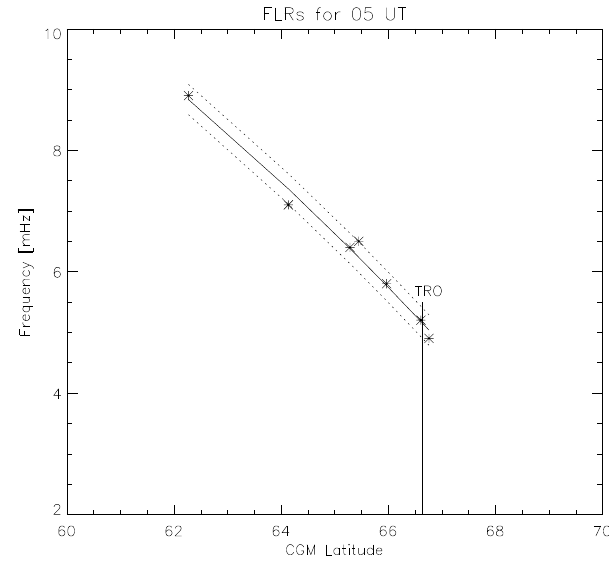
Fig. 6. Latitude variation of the FLR frequencies obtained from IMAGE magnetometer data for 04:30–05:30 UT, 24 March 2001. The latitude of the DOPE instrumentation is